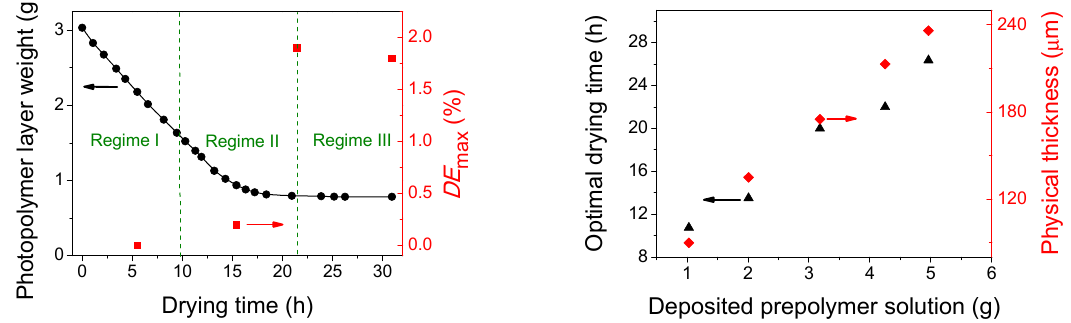
Figure 2. ( a ) Weight loss (black circles) and maximum diffraction efficiencies ( DE max , red squares) of a photopolymer layer when an initial amount of 3.030 g prepolymer solution is deposited over a glass plate. ( b ) Optimal drying time (black triangles) and physical thickness (red diamonds) obtained for different amounts of prepolymer solution deposited. Errors are ± 0.001 g in the photopolymer layer weight and deposited prepolymer solution, ± 0.017 h in the drying time and optimal drying time, ± 1 µ m in the physical thickness and ± 0.6% in the maximum diffraction efficiencies ( DE max